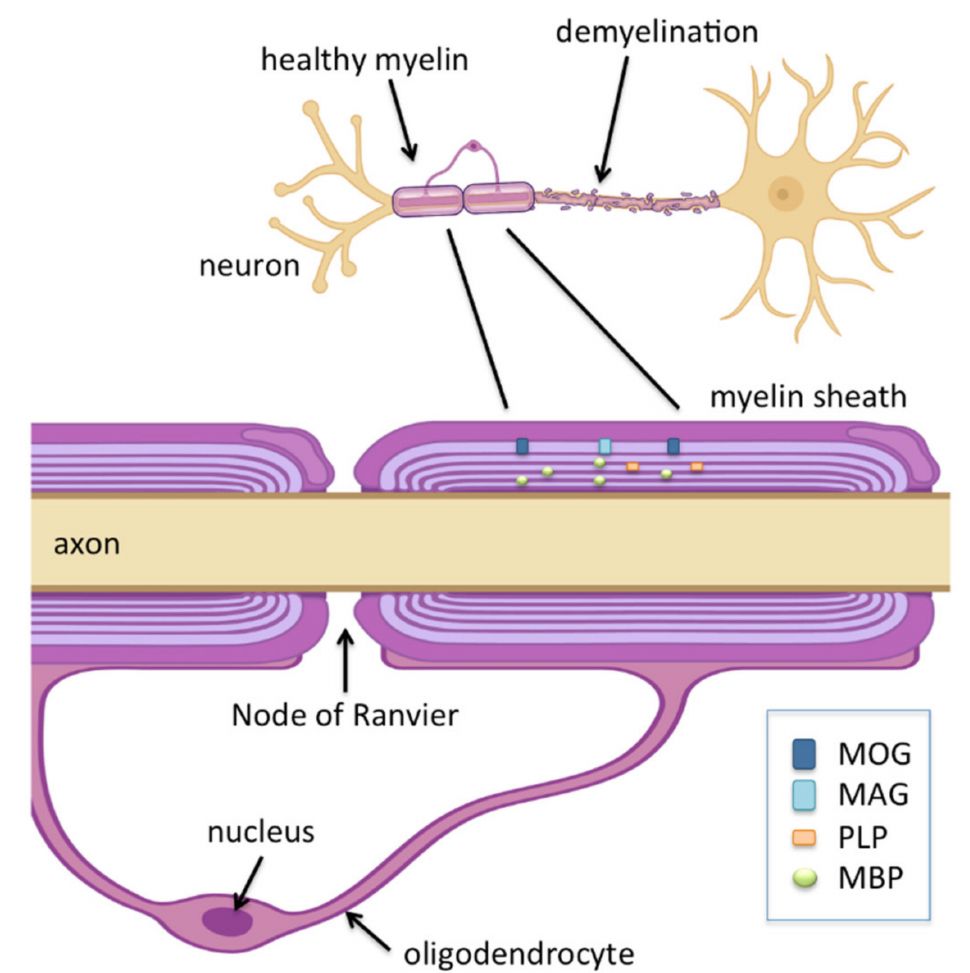
Figure 2. Key components of the myelin sheath, the protective layer around axons. Myelin basic protein (MBP) and proteolipid protein (PLP) are the most abundant proteins in CNS myelin. Myelin oligodendrocyte glycoprotein (MOG) and myelin-associated glycoprotein (MAG) are minor com- ponents. Oligodendrocytes, large glial cells found in the CNS, play an important role in myelin biogenesis. Oligodendrocyte precursor cells (not shown), which comprise a large population of proliferating cells in mature CNS, play a role in